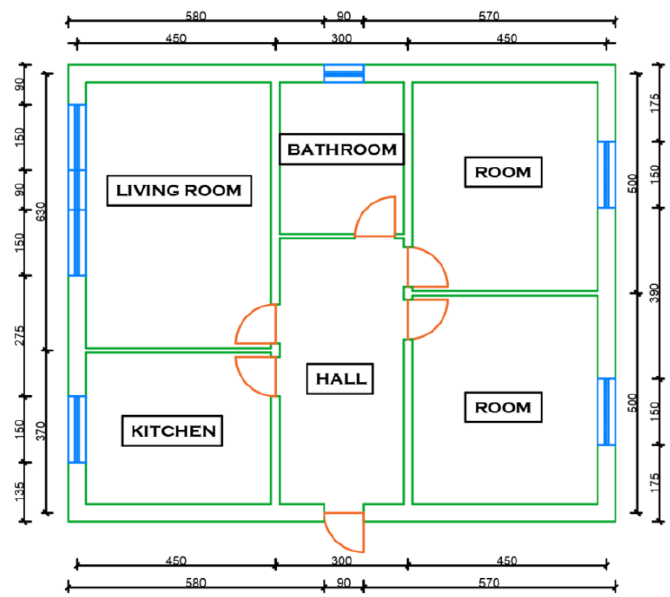
Figure 1. Plan of the analyzed building.